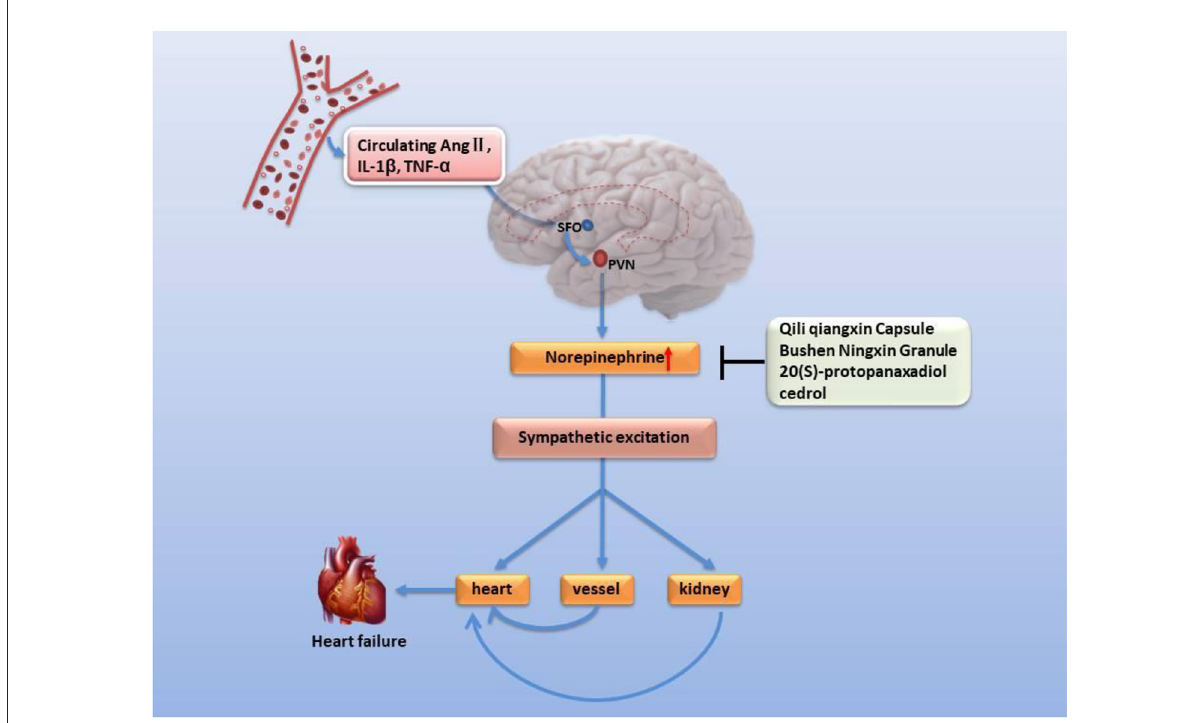
FIGURE2 Inhibitory effect of classic formulations and their active ingredients on norepinephrine secretion and neural excitability in the hypothalamus. Circulating pro-inflammatory factors enhance sympathetic excitability and the risk of heart failure. SFO’s perception of circulating proinflammatory factors leads to increased secretion of norepinephrine in PVN neurotransmitters and promotes sympathetic excitability, resulting in microvascular contraction, renal fluid retention and increased renin release, raising the level of angiotensin II and aldosterone in blood, elevating heart rate and arrhythmia, and causing left ventricular